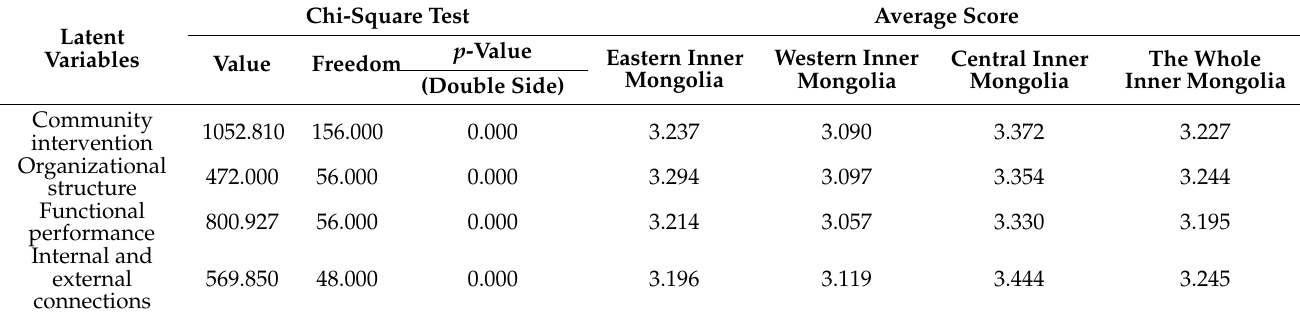
Table 3. Scores of the mean and chi-square test of community intervention in each